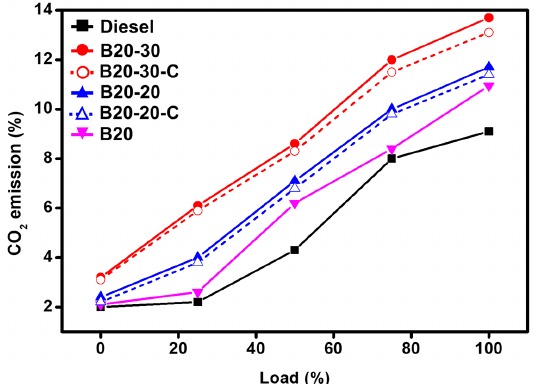
Figure 9. Comparative graphical illustration of emission of CO 2 from diesel and blends vs. load (%) (with ZnO-GS and ZnO-C). B20 is D-COME, i.e., discarded cooking oil methyl ester, which is blended with 20% commercial diesel; B20-20 is the blend of B20 with 20 mg of ZnO-GS/C; B20-30 is the blend of B20 with 30 mg of ZnO-GS/C.